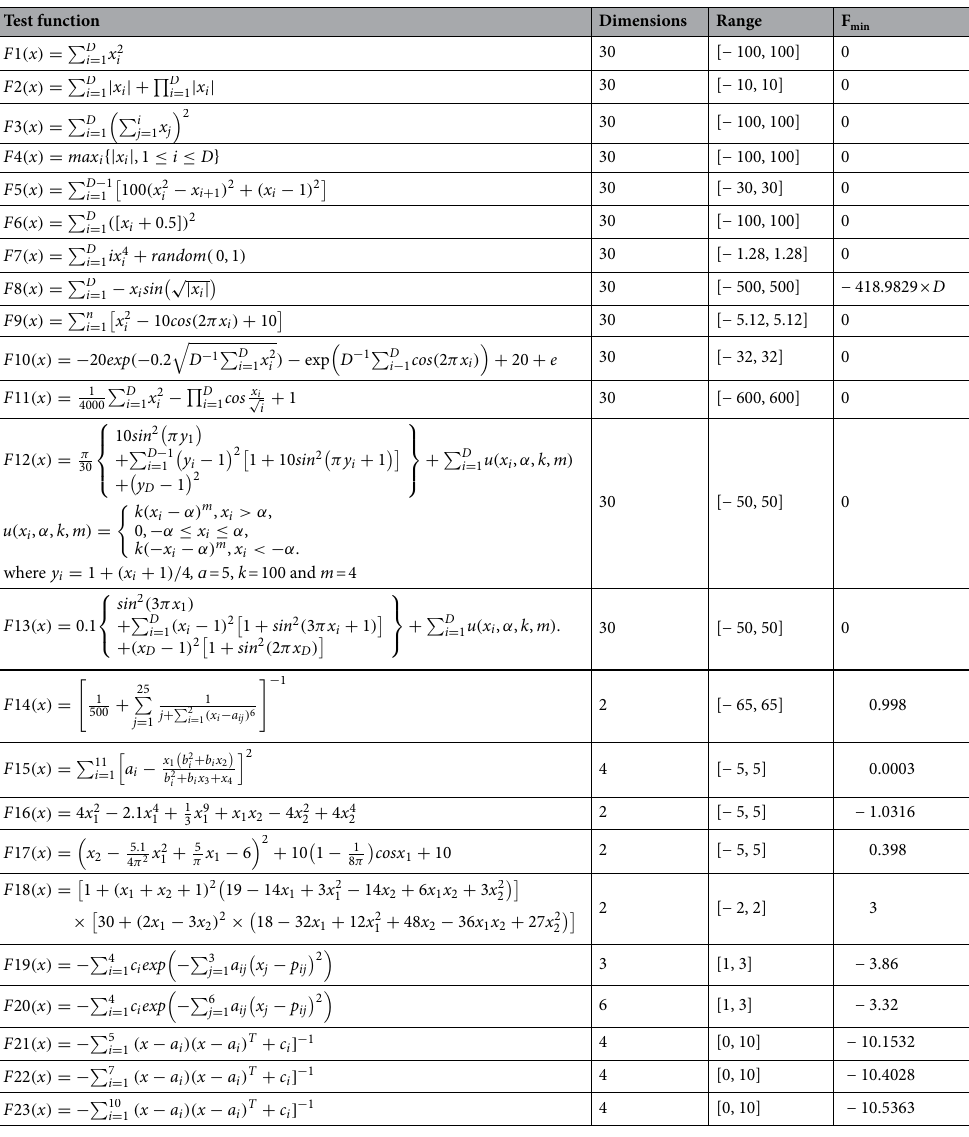
Table 1. The benchmark